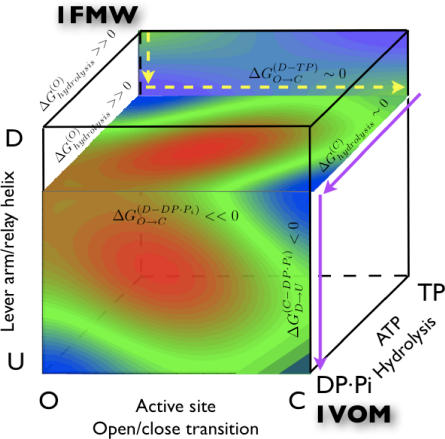
A Schematic Illustration of Thermodynamic Coupling between Processes Involved in the Myosin Detached States (Characterized by the PDB codes 1FMW, 1VOM; see Table 1)The open(O)/close(C) transition of the active site, the hydrolysis of ATP (TP versus DP·Pi), and the rotation of the converter domain (Down versus Up); different converter orientation is presumed to be correlated with different relay helix conformations as implied in the X-ray structures. The schematic free-energy maps (red indicates high-energy region, blue low-energy region, and green intermediate-energy region) are sketched based on results from the previous QM/MM simulations [29], current PMF simulations, and thermodynamic cycle considerations. The dashed and solid arrows indicate a likely sequence of events during the 1FMW → 1VOM transition.